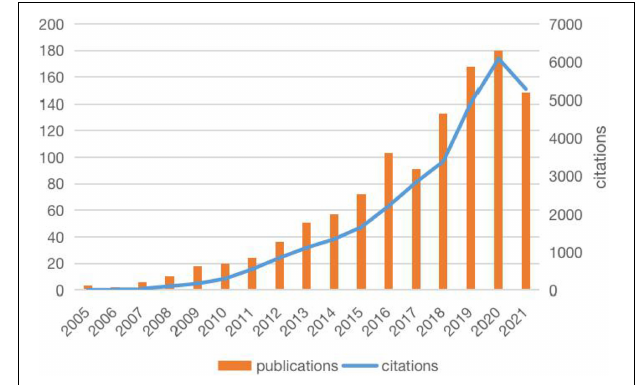
FIGURE 1 | Trends in publications and citations in metabolomics and coronary artery disease research (2005–2021). The publications generally showed an upward trend, annual citations were also increased during the past